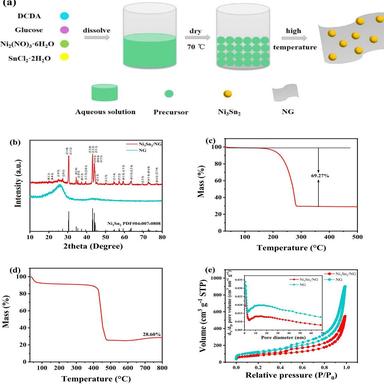
(a) A schematic illustration of the synthetic process of Ni3Sn2/NG composite. (b) XRD patterns of Ni3Sn2/NG and NG. TGA curve of (c) AB-S composite and (d) Ni3Sn2/NG composite. (e) Nitrogen absorption-desorption isotherms of Ni3Sn2/NG, NG and corresponding pore size distribution (inset).